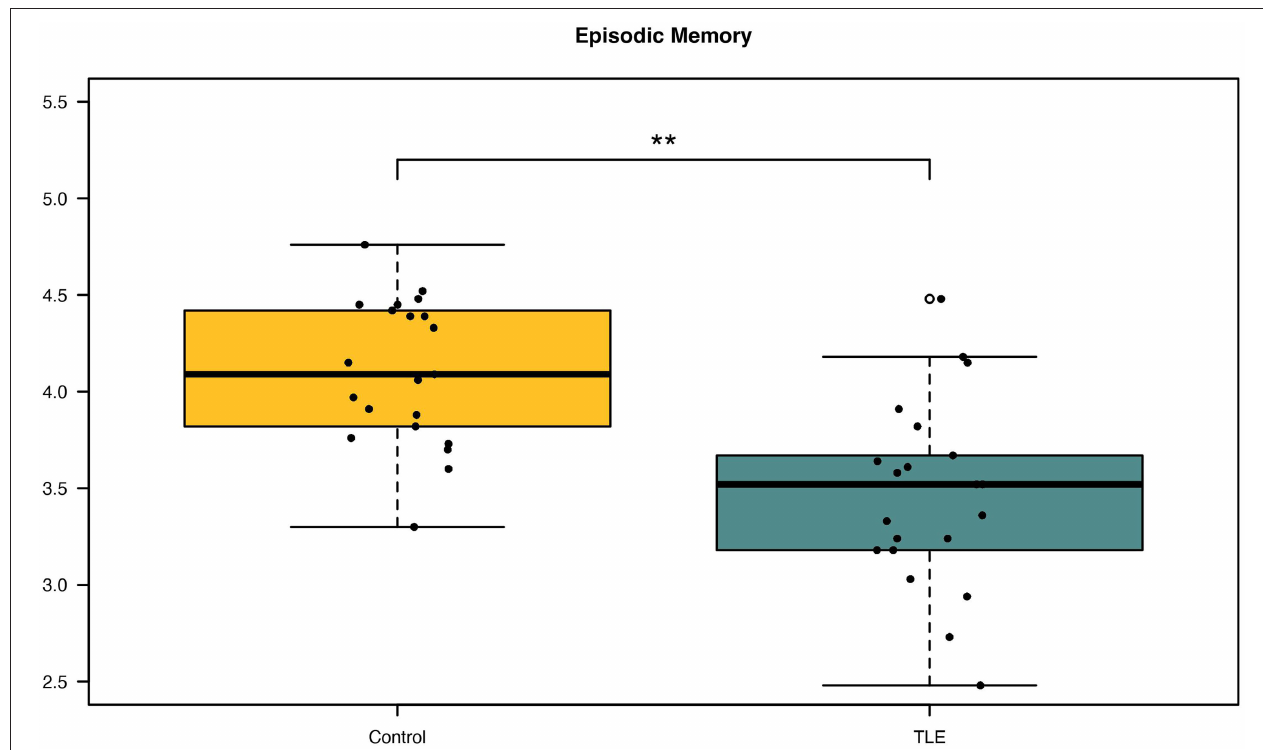
FIGURE 1 | Differences in episodic memory scores between patients and controls. Patients with newly diagnosed temporal lobe epilepsy (TLE) were observed to have significantly decreased episodic memory scores compared with controls. ** p < 0.001.